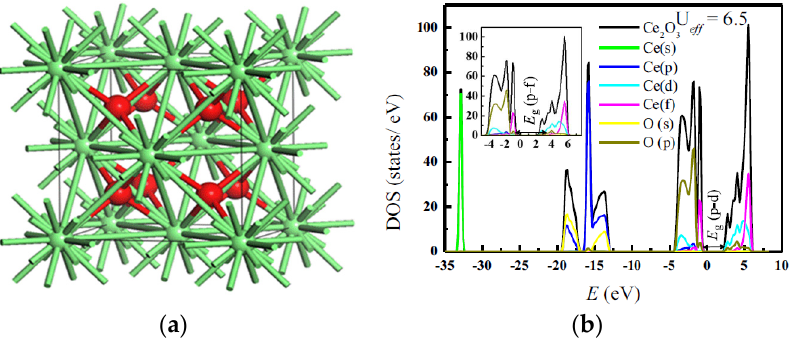
Figure 2. ( a ) Cubic fluorite structure of the lanthanide dioxide. ( b ) The theoretically predicted total and partial density of states for Ce 2 O 3 sesquioxides [14]. Table 1. Bulk modulus B, its pressure derivative B ′ , and the phase transition pressure for the complete series of Ln 2 O 3 . Reproduced from [12].